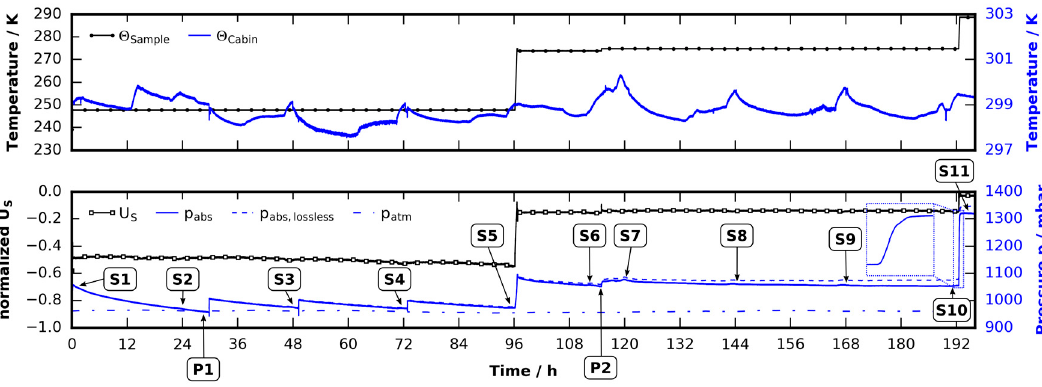
Figure 5. Sample and cabin temperature (Θ (cid:2903)(cid:2911)(cid:2923)(cid:2926)(cid:2922)(cid:2915) ,Θ (cid:2887)(cid:2911)(cid:2912)(cid:2919)(cid:2924) ) as well as cell pressure (cid:1868) (cid:2911)(cid:2912)(cid:2929) and TEC supply voltage U S obtained during a long-term experiment with a THF clathrate sample. The pressure p abs has been corrected by fluctuations in cabin temperature (see Section 4.4.2). p abs,lossless shows the pressure in a lossless cell, which is obtained by subtracting an integrated pressure loss rate from p abs . The markers S1–S11 indicate a series of consecutive µ CT scans. Markers P1 and P2 label points of irregular pressure behavior: at P1, the cell pressure crosses the atmospheric pressure p atm , which cannot be explained by leakage. The increase in pressure at P2 is five times the increase in pressure caused by thermal expansion due to a temperature increase of 1 K. The inset at the far right shows a zoom into the pressure signal during the decomposition of the clathrate.